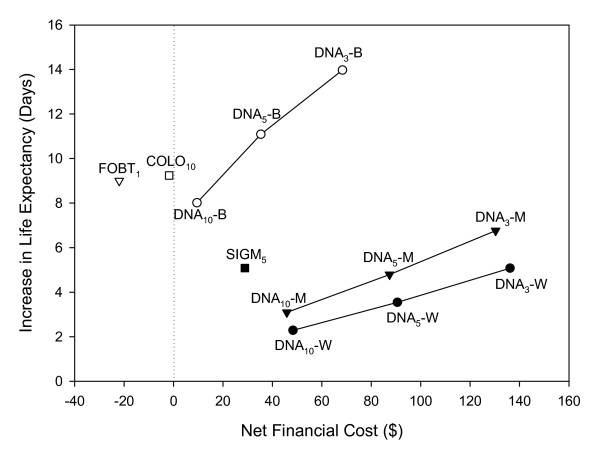
Cost-effectiveness of CRC screening under different scenarios. Abbreviations: CRC, colorectal cancer; DNA3, DNA5, and DNA10, stool DNA testing every 3, 5, and 10 years, respectively; -W, under the worst case scenario (the same with the base-case estimates) in which the sensitivity of stool DNA testing for small adenoma, large adenoma, and colorectal cancer, and the specificity are 8%, 15%, 52%, and 94% based on Imperiale et al study [10]; -M, under the moderate case scenario in which the corresponding estimates are 8%, 18%, 85%, and 94% based on meta-analysis [10-13, 16]; -B, under the best case scenario in which the corresponding estimates are 8%, 82%, 91%, and 93% based on Ahlquist et al study [10]; FOBT1, fecal occult blood testing every year; SIGM5, sigmoidoscopy every 5 years; COLO10, colonoscopy every 10 years.